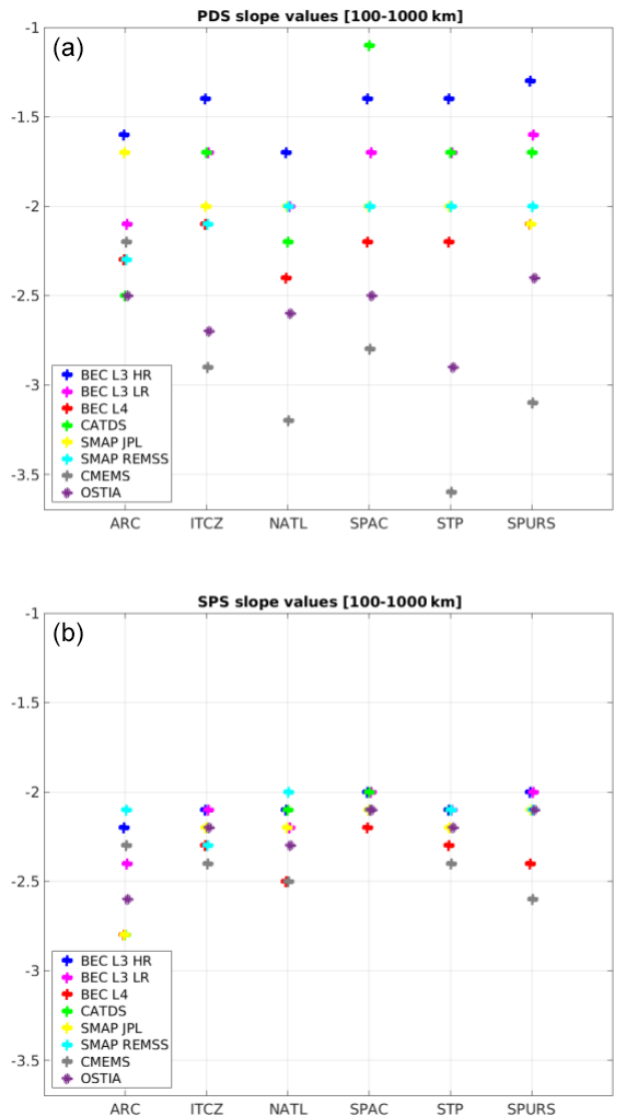
Figure 16. Slopes of the power density spectra (a) and the singu- larity specter analysis (b) of the different SSS products. The cor- responding slopes of the PDS and SPS of OSTIA SST are also in- cluded as a